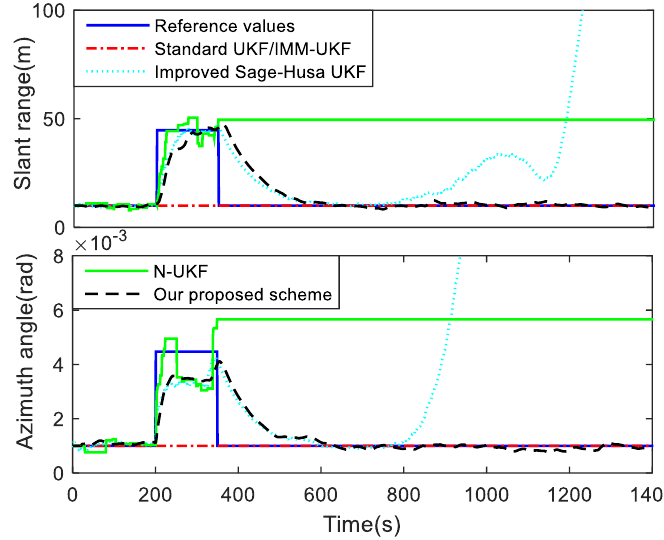
Figure 5. Estimated measurement noise standard deviations for Case 2.